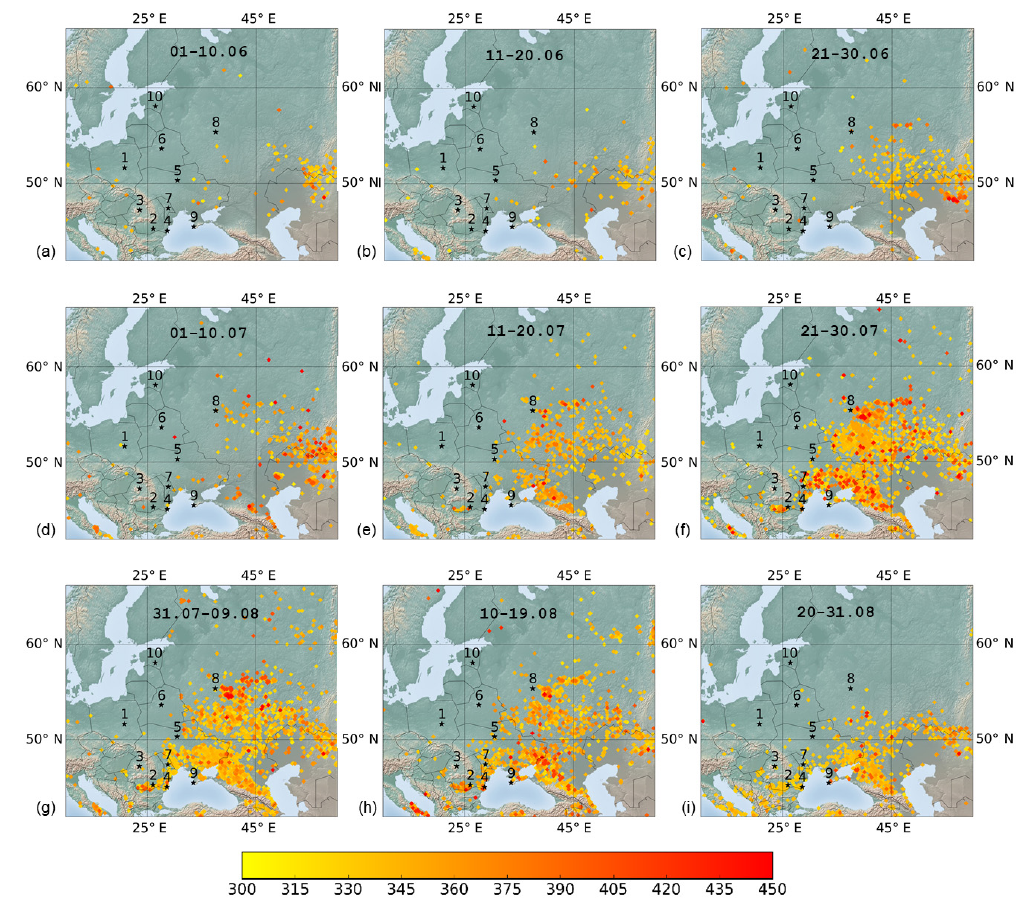
Figure 2. Fire locations and brightness temperature (in K) of fire pixels in the ETR and Eastern Europe (40–65 ◦ N and 10–60 ◦ E) detected by MODIS and accumulated over 10-day periods from 1 June to 20 August – (a) 1–10 June, (b) 11–20 June, (c) 21–30 June, (d) 1–10 July, (e) 11–20 July, (f) 21–30 July, (g) 31 July–9 August, (h) 10–19 August – and a 12-day period of (i) 20–31 August. Black stars and numbers indicate the position of AERONET stations also shown in Fig. 1: 1 – Belsk; 2 – Bucharest; 3 – Cluj-Napoca; 4 – Eforie; 5 – Kyiv; 6 – Minsk; 7 – Moldova; 8 – Moscow; 9 – Sevastopol; 10 –